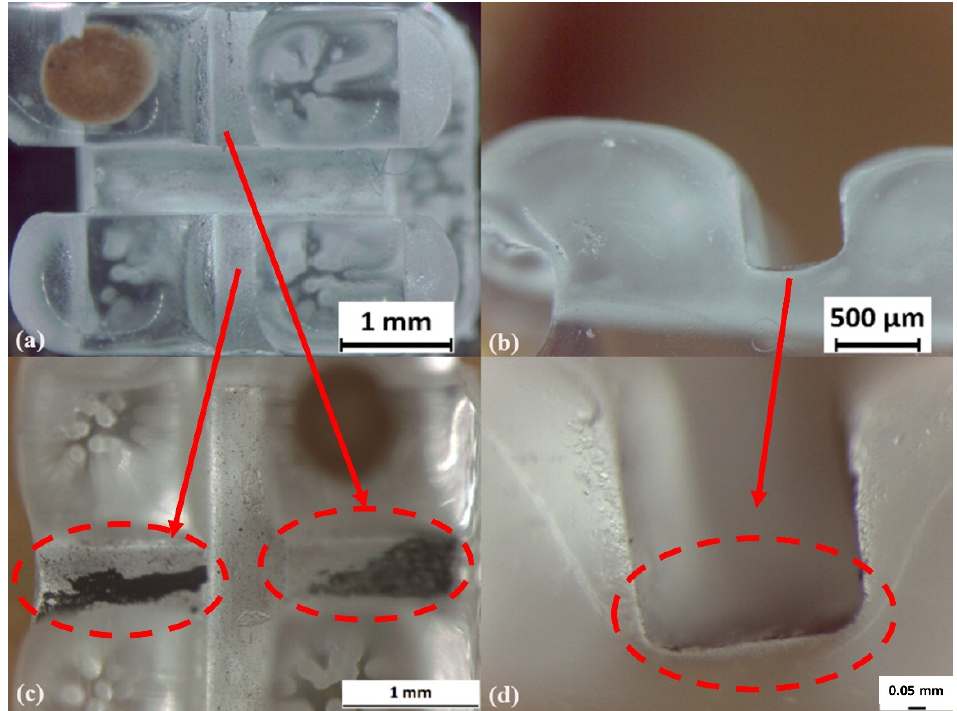
Figure 4. AB1 bracket (Manufacturer 1) in top and side view: ( a , b ) before the test; ( c , d ) after the test. Table 6. XRF results of the aesthetic bracket. Percentage by weight.